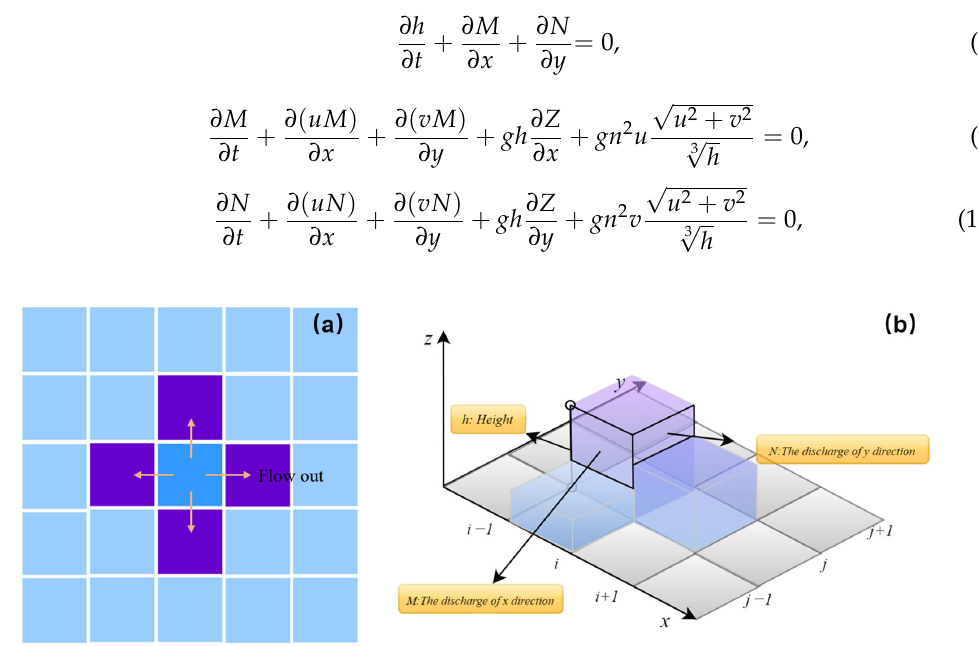
Figure 7. ( a ) Von Neumann ‐ type neighborhood. ( b ). Cellular space difference diagram.